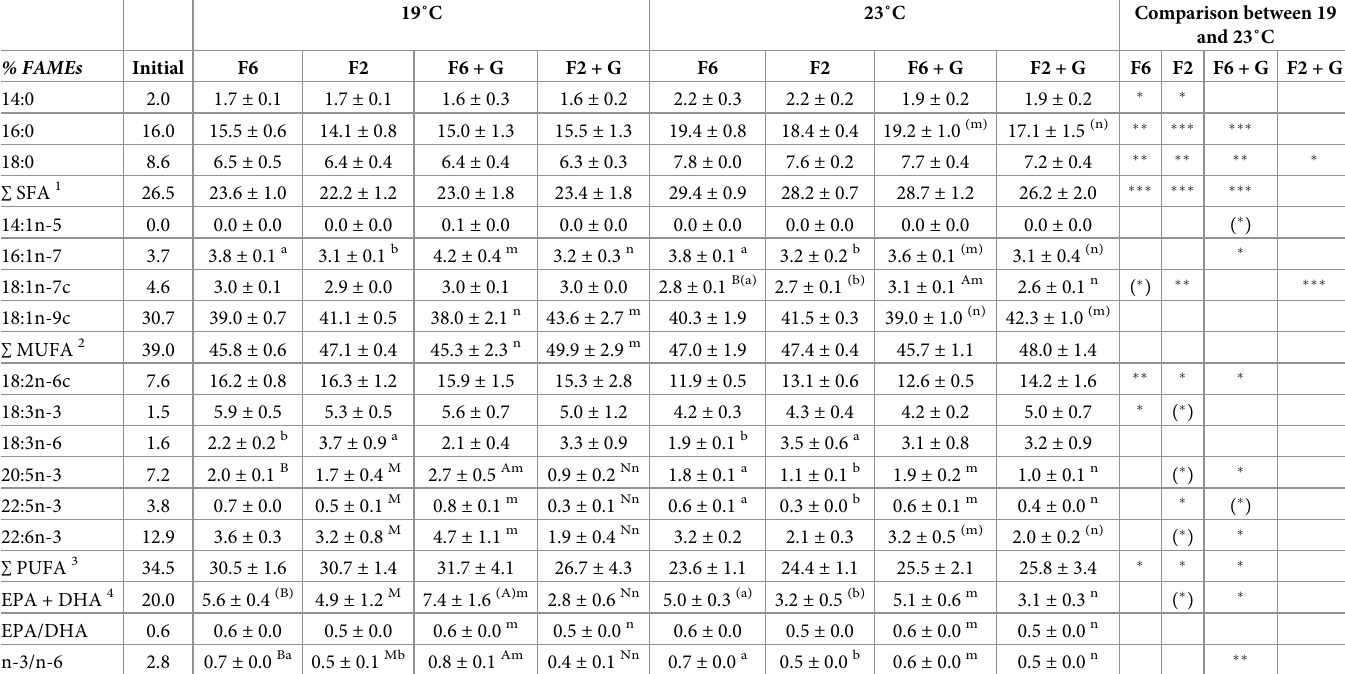
Table 6. Fatty acid composition (percentage of total fatty acid methyl esters (% FAMEs)) of liver tissue of gilthead sea bream at the end of the 8 week feeding trial held at two different temperatures (19˚C and 23˚C). F6 and F2 indicate the feeding with the control diets containing 6% and 2% DM fish oil, respectively. +G indicates feeding diets supplemented with 0.15% DM genistein.